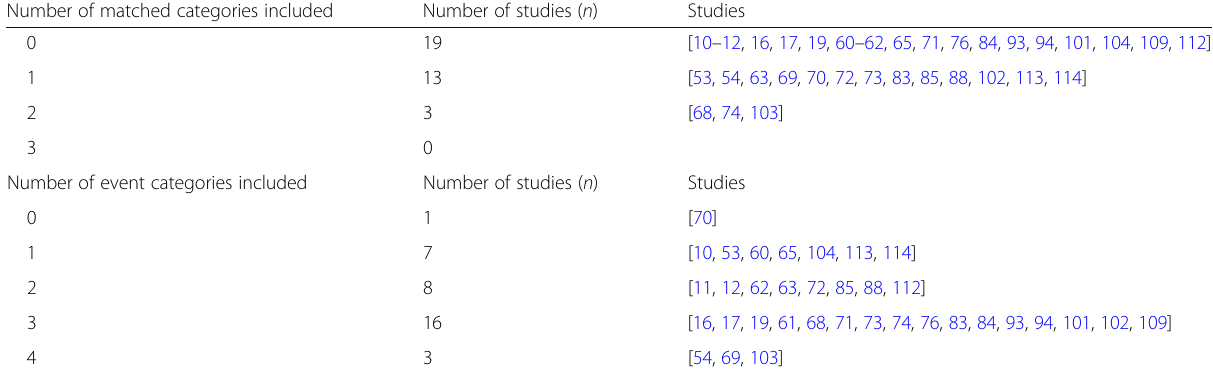
Table 5 The number of categories of contextual variables included in the analysis; where a category was not applicable to the study, it was counted as included